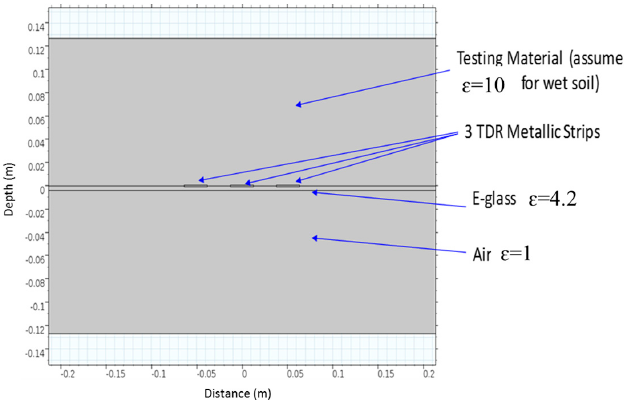
Figure 9. Finite element method (FEM) model.